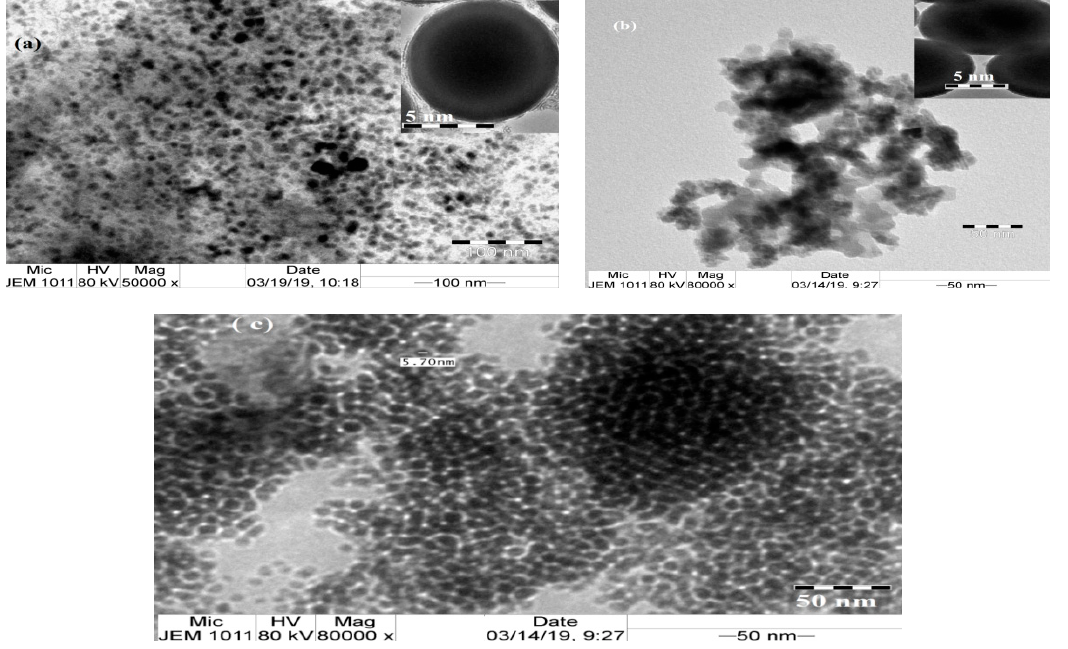
Figure 6. TEM micrographs of ( a ) Si-IL, ( b ) Fe 3 O 4 -Si-IL, and ( c ) Fe 3 O 4 .